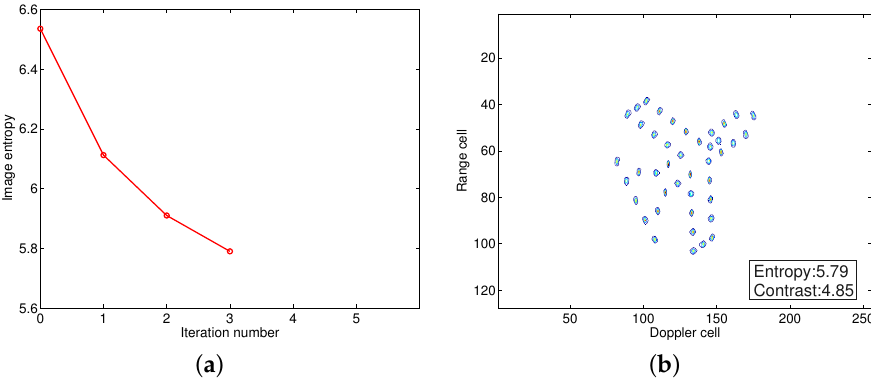
Figure 6. Experimental results using the new imaging approach. ( a ) Variation of the image entropy. ( b ) ISAR image based on the new imaging approach.